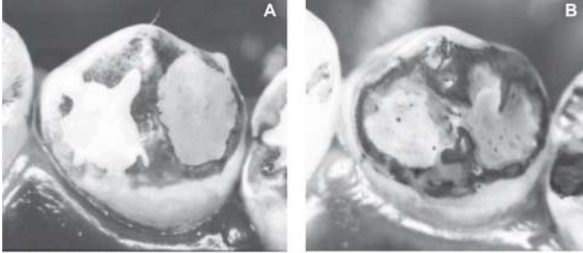
FIGURE 1- Photographs of specimens E26 and E27, left mandibular first premolar, presenting occlusal sealing at two distinct areas with the Prisma Shield sealant (S2), at the initial period (7 days) (T0) (A) and 11 years (T3) (B) after occlusal